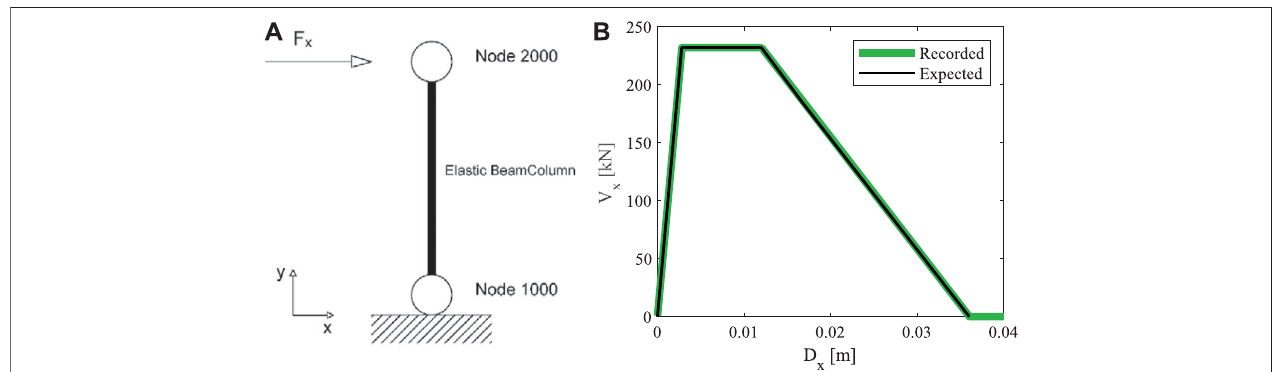
FIGURE 8 | (A) Single dowel connection modeling scheme. (B) Comparison between the expected and the recorded pushover curves.